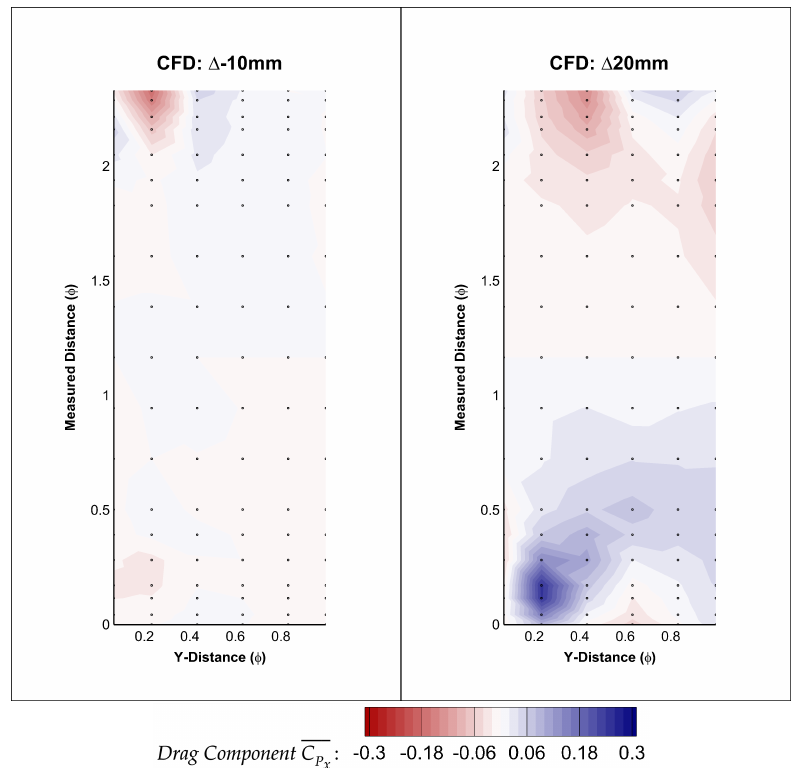
Figure 25. Wheel displacement wheel arch pressures: CFD ∆ drag